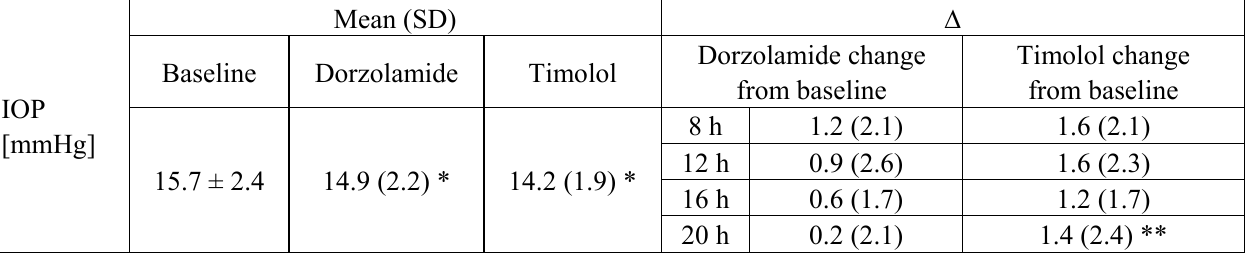
Table 2. Changes in IOP during add-on therapies.